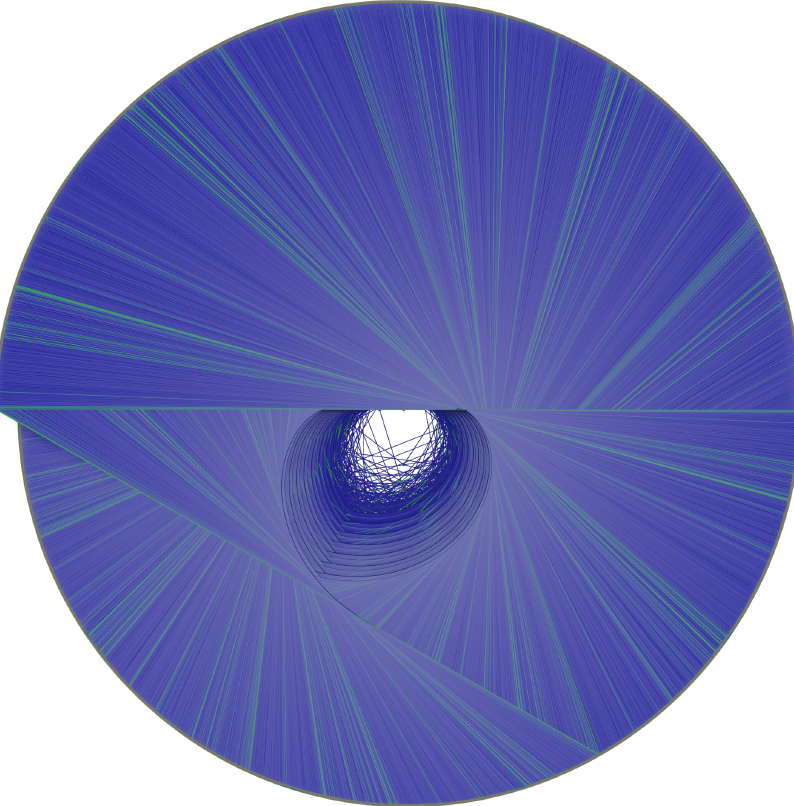
Figure 22. Orthogonal view of the Golden Automaton starting from 1 (in blue) obtained from the code in [42]. All its intersections with the automaton starting independently from 1457 (the first A g in the forward Collatz trajectory of 127) are shown in green. As expected from our 2D works in Section 7, the Golden automaton starting from 1 covers all numbers. This figure also provides the first trigonometric representation of the inflation propensity of Collatz orbits, which Bocart [19] has proven constitutes a reliable proof-of-work for blockchain applications: the number of green lines (overlapping the inverse orbit of 1457 and that of 1) is directly tied to the inflation propensity of a given orbit; simply put, the more an orbit inflates, the more green lines are shown on this disc, but their distribution cannot be faked and thus forms a functional authentication fingerprint. As green lines also represent particular trajectories, this figure also suggests that other promising proofs-of-work, comparable with that of Bocart, could be obtained from the study of non-ergodic